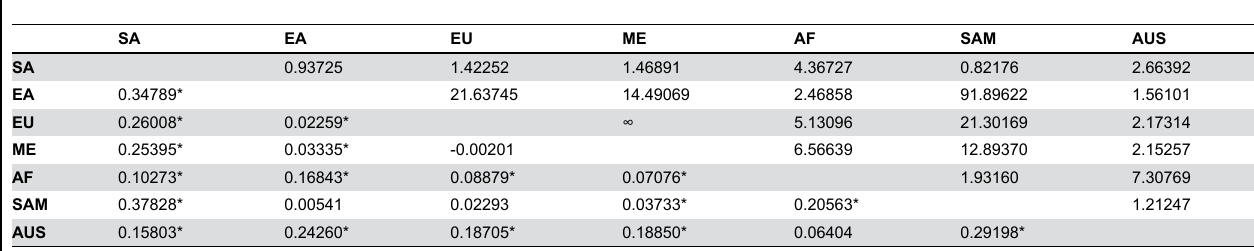
Table 4. Pairwise genetic distance (Fst in lower diagonal) and gene flow (Nm in upper diagonal) between different populations of Echinococcus granulosus sensu stricto calculated from nucleotide sequence of mitochondrial cox1